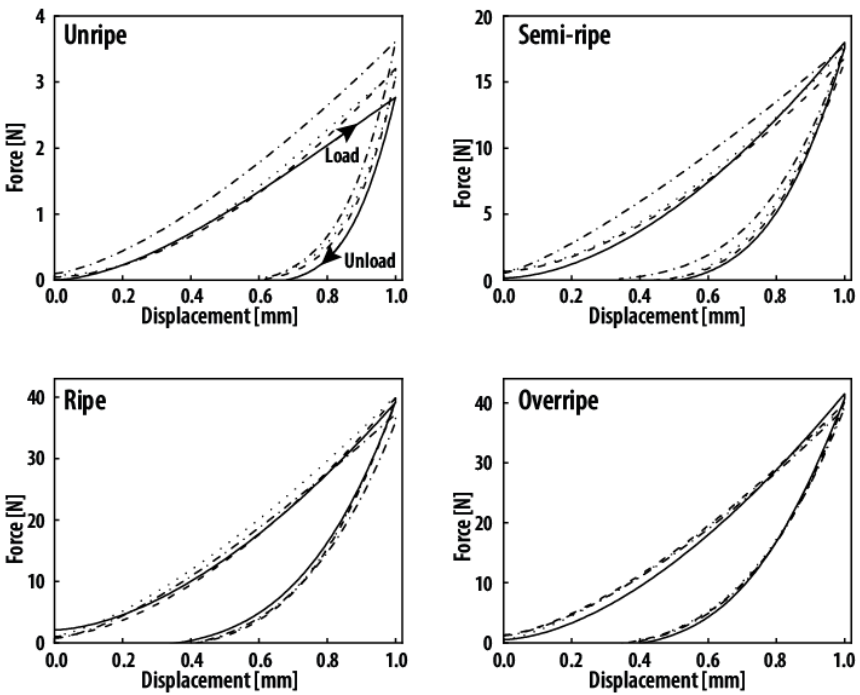
Figure 4. Loading and unloading curves for the bean. Dashed lines represent other samples.